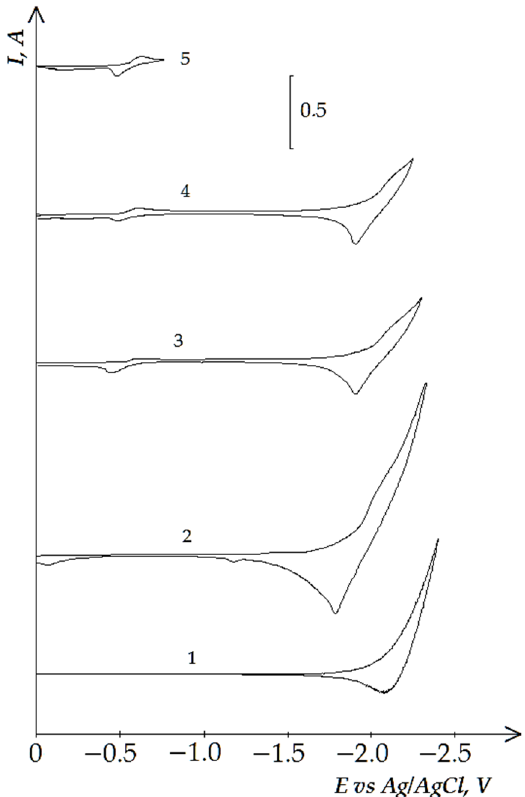
Figure 15. Cyclic voltammograms of electrochemical coreduction of Nd 3+ and Fe 2+ ions on the tungsten electrode in the equimolar KCl-NaCl melt at 973 K and polarization rate of 0.2 V/s recorded at different reverse potentials: curves 1 and 2 ( − 2.4 V), curve 3 ( − 2.23 V), curve 4 ( − 2.25 V), curve 5 ( − 0.75 V). Concentrations of NdCl 3 : curve 1—0 mol/cm 3 , curves (2–5)—4.0 × 10 − 4 mol/cm 3 . Concentrations of FeCl 3 : curves (1 and 2)—0 mol/cm 3 , curves (3–5)—5.0 × 10 − 5 mol/cm 3 . A square of the cathode is 0.64 cm 2 .